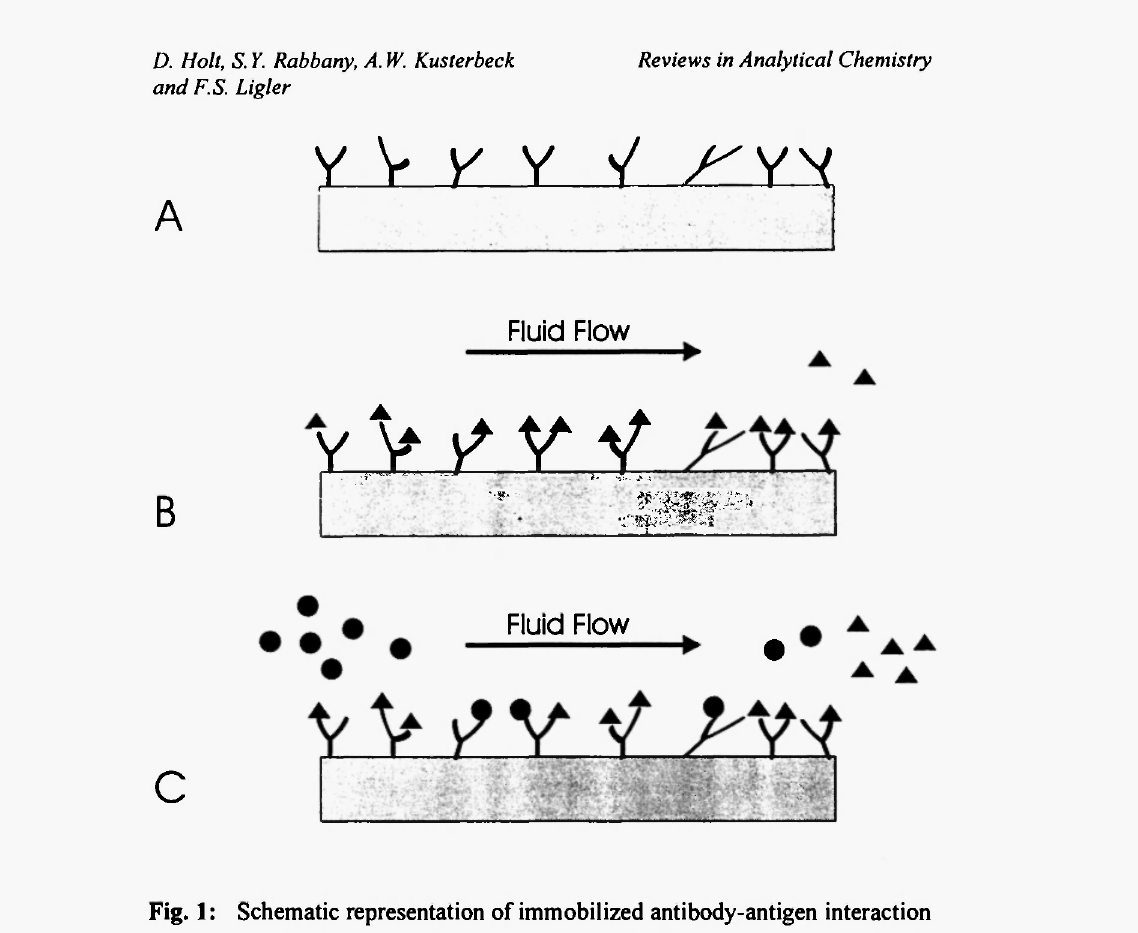
Fig. 1: Schematic representation of immobilized antibody-antigen interaction in the flow immunoassay, (a) Antibodies are immobilized via cross-linking onto the solid support, (b) The antibody binding sites are saturated with fluorophore-labeled antigens. Then buffer flow is initiated which washes off non-specifically bound labeled-antigen (not indicated) and establishes a slowly but continually decreasing fluorescence background from the spontaneous dissociation of labeled- antigen from the surface bound antibody, (c) The reagent to be detected is introduced into the buffer stream over the assay. The incoming analyte displaces the bound labeled-antigens, rendering a signal measured by a fluerometer